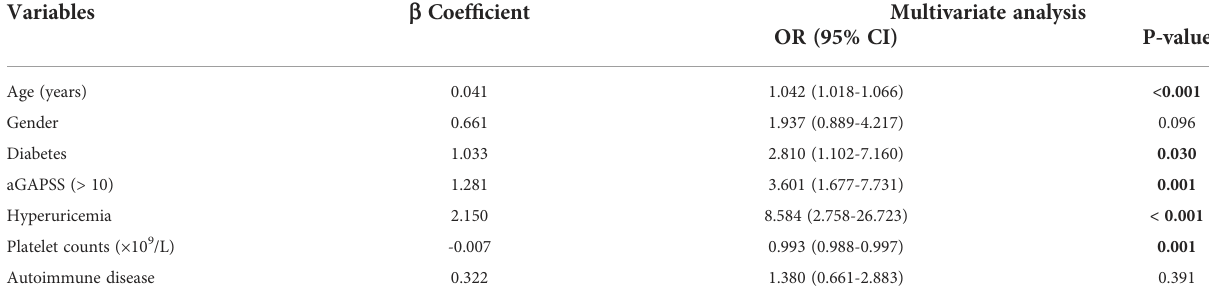
TABLE 3 Multivariate analysis of IS occurrence based on the training